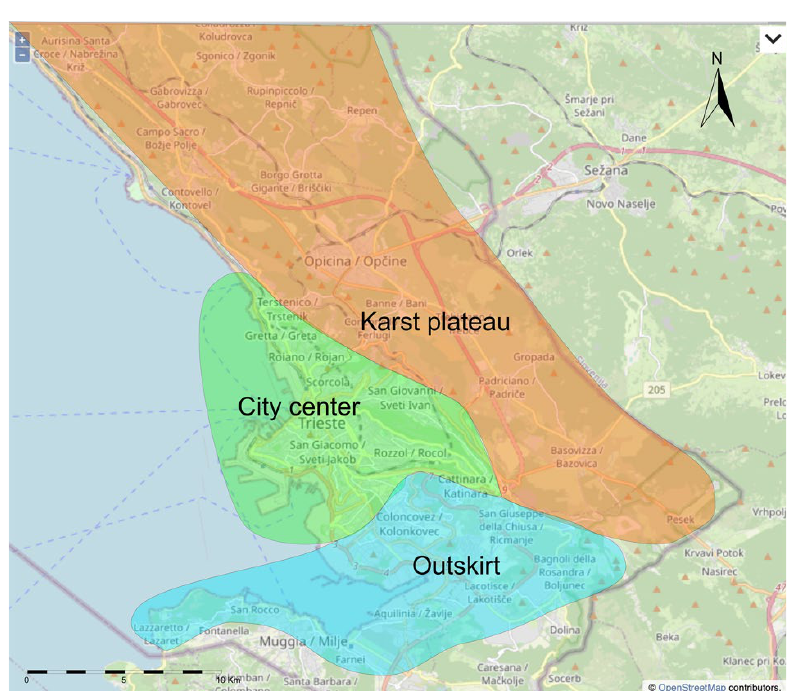
Figure 2. The city of Trieste, where we highlighted in different colors the extension of the three types of areas considered in this work; (i) the city center, where household heating is based mainly on natural gas and PM source is conditioned mostly by the traffic(green); (ii) the Karst plateau where traffic is rather low and where household heating is based mainly on solid and liquid fuel burning (brown); (iii) the outskirts of the city where the contribution of different sources of PM (traffic, heating, industries) are difficult to separate (blue).